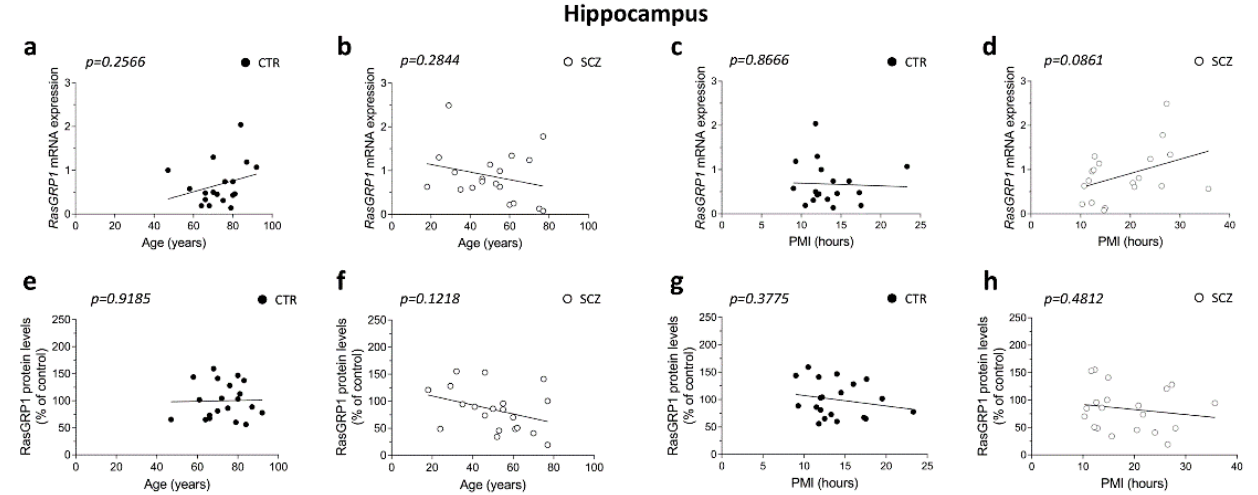
Figure 3. Lack of correlation between RasGRP1 mRNA and protein levels with age and PMI in the hippocampus of schizophrenia patients. Analysis of correlation between age and mRNA and protein levels of RasGRP1 in post-mortem hippocampus of ( a , e ) control subjects (CTR, RasGRP1 mRNA: n = 18, RasGRP1 protein: n = 20) and ( b , f ) SCZ patients (SCZ, RasGRP1 mRNA: n = 19, RasGRP1 protein: n = 20). Analysis of correlation between PMI with mRNA and protein levels of RasGRP1 in DLPFC of ( c , g ) control subjects (CTR, RasGRP1 mRNA: n = 18, RasGRP1 protein: n = 20) and ( d , h ) SCZ patients (SCZ, RasGRP1 mRNA: n = 19, RasGRP1 protein: n = 20). 3.4. Unaltered RasGRP1 mRNA and Protein Levels in the Hippocampus of Schizophrenia Patients